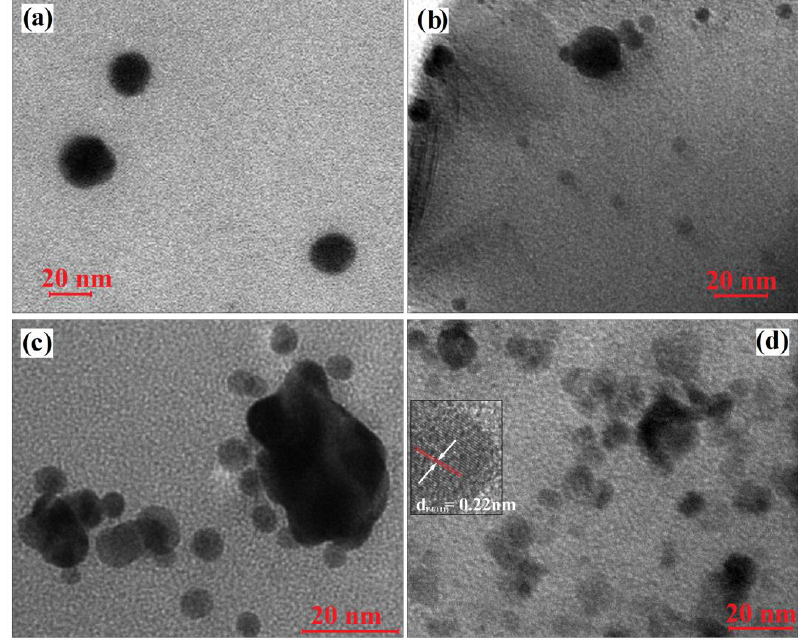
Figure 7. Transmission electron microscopy (TEM) images of M1 ( a ), M1-Ag ( b ), M1-Au ( c ) and M1-Pd ( d ) nanocomposites.